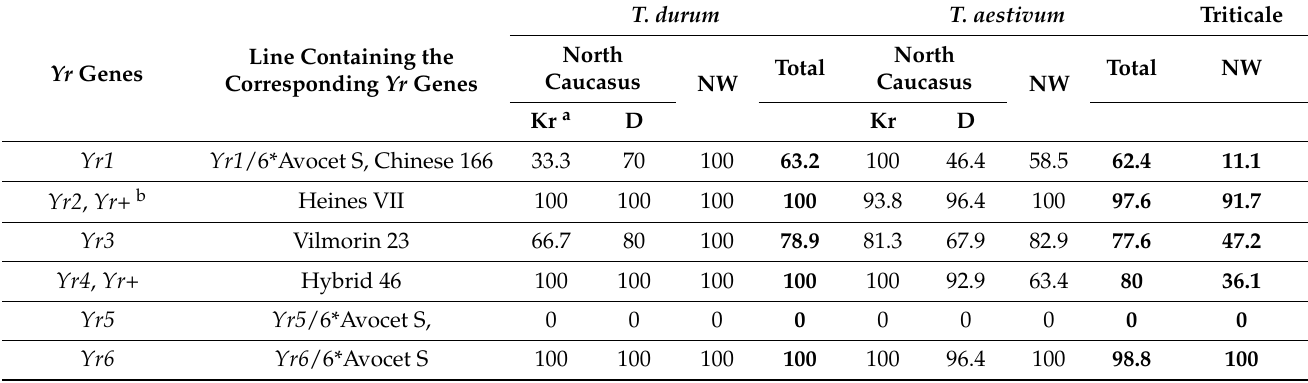
Table 1. Virulence frequency of P. striiformis collections of isolates originating from wheat and triticale in Russian regions.